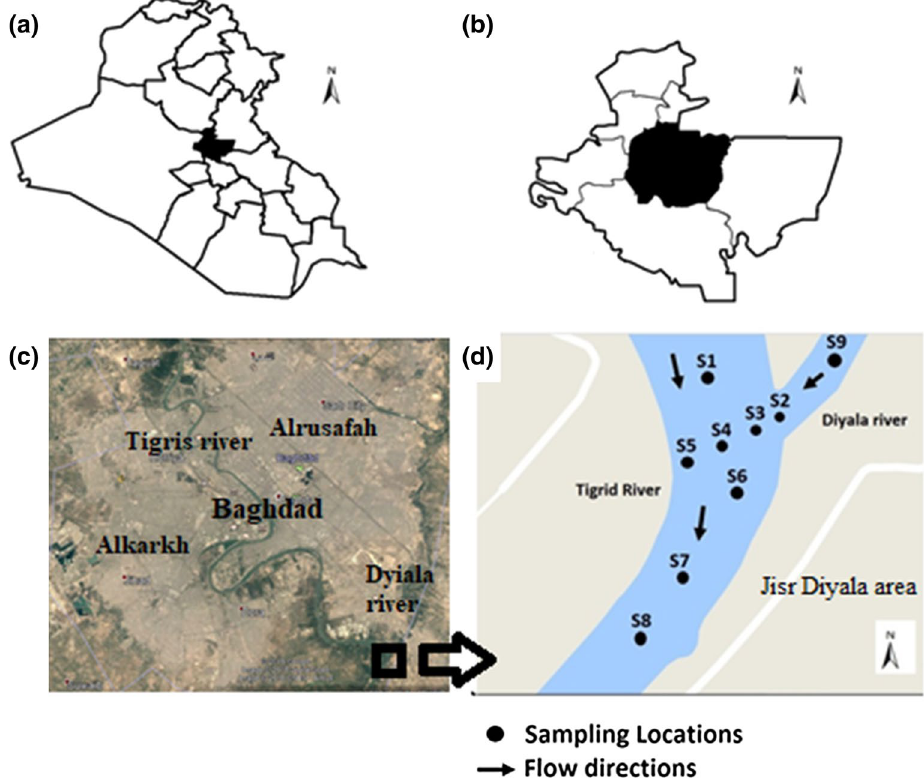
Fig. 1 Map of the study area,